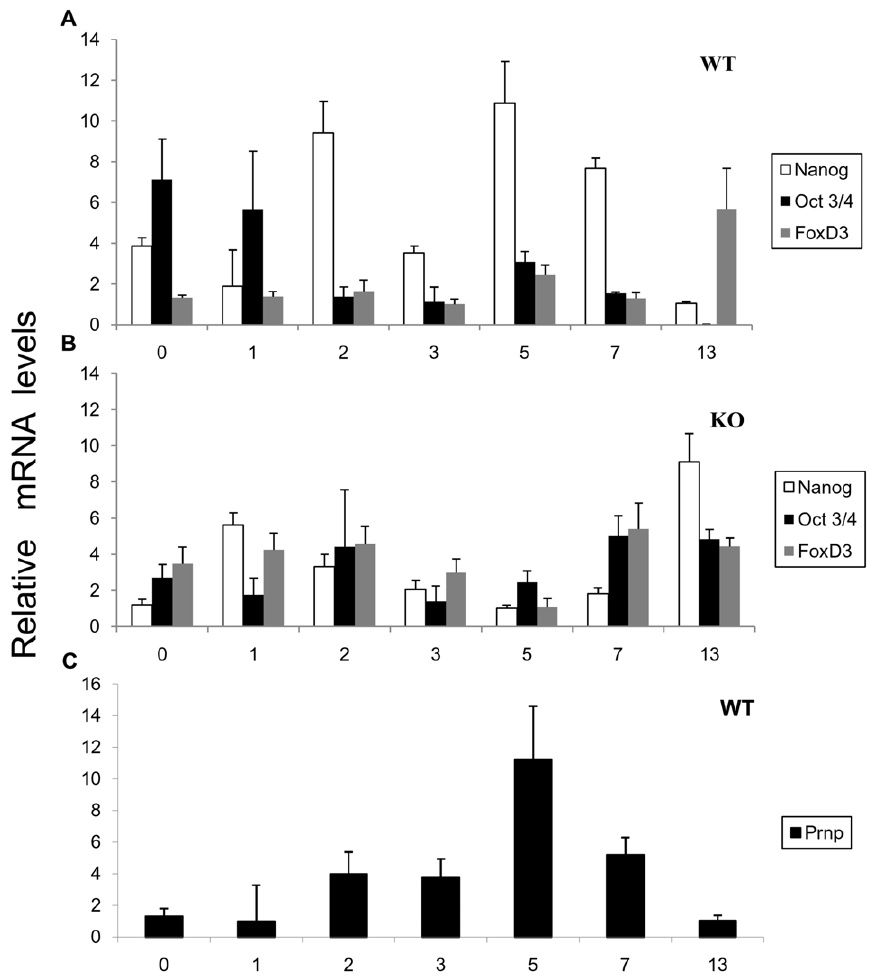
Figure 2. Pluripotency in the WT and Prnp -null cell lines. WT EB mRNA ( A ) and KO EB mRNA ( B ) expression patterns of three pluripotency genes during differentiation. Note the lack in the KO line ( B ) of an increase in Nanog expression on Day 5. C) WT EB mRNA expression pattern of Prnp during differentiation (Days 0, 1, 2, 3, 5, 7 and 13). Prnp is expressed at its highest levels on Day 5 (Error bars, s.e.m.).